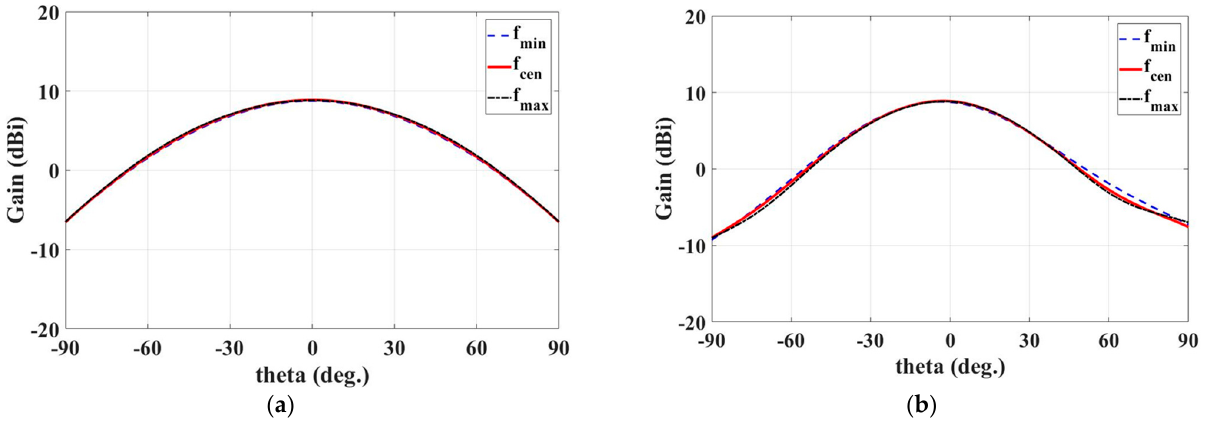
Figure 18. Element antenna patterns of S-STEP SAR payload in ( a ) azimuth and ( b ) elevation.